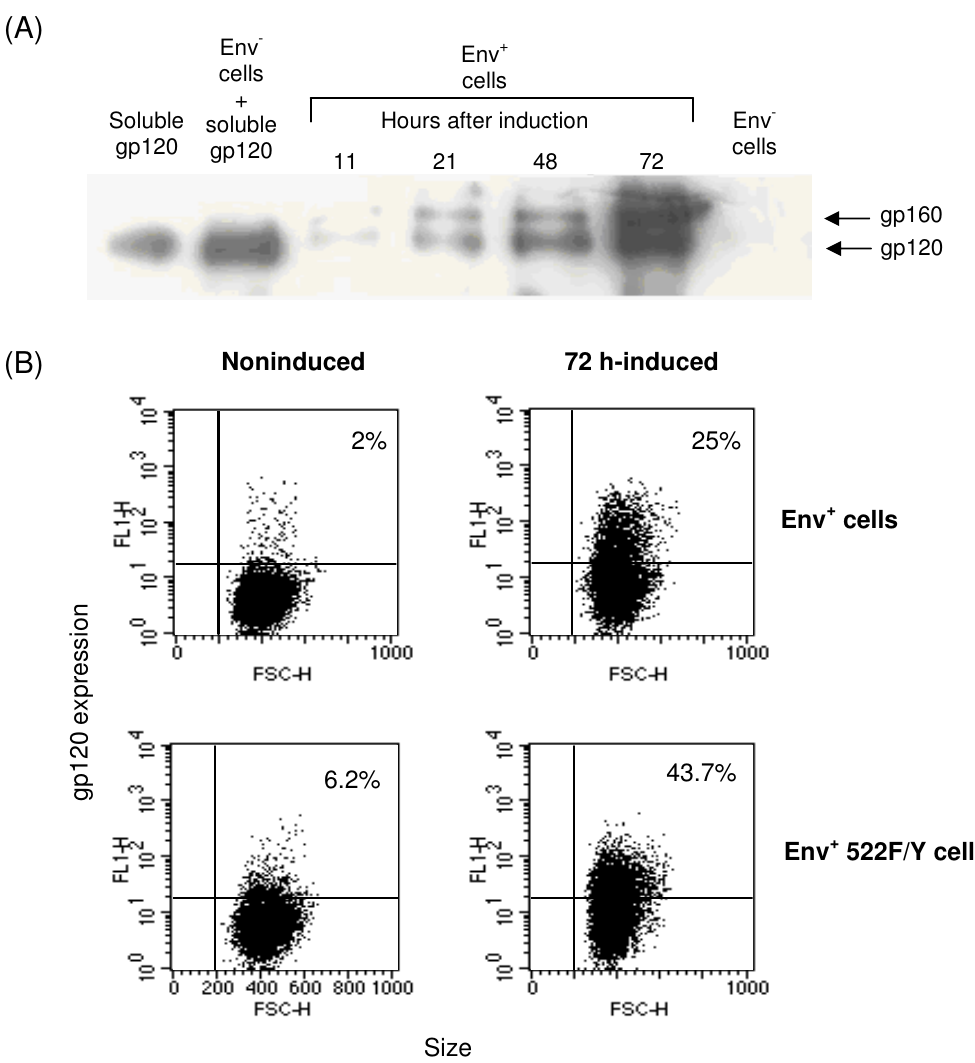
FIGURE 1 . Tetracycline-inducible expression of HIV-Env proteins in Jurkat cells. Expression of the HIV-Env protein in transfected Jurkat cells was repressed when tetracycline was present in the culture medium (noninduced cells) and induced after its removal (induced cells). A time-dependent accumulation of envelope proteins in the induced cells was detected (A) by Western blot analysis of the immunoprecipitation products of cell extracts and (B) by flow cytometry on whole cells, using a rabbit anti-gp120 polyclonal antibody. In the Western blot, immunoprecipitates were separated by SDS-PAGE (7% gel) and transferred to a nitrocellulose membrane. After incubation with the anti-gp120 antibody and a second antibody coupled to horseradish peroxidase, the blot was then treated with a chemiluminescent peroxidase substrate. For the flow cytometry, a second antibody coupled to fluorescein isothiocyanate was used.